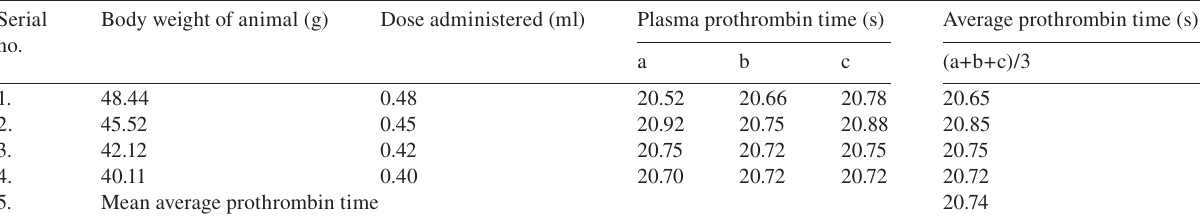
Table 2 In vivo anticoagulation action of coumarin in albino